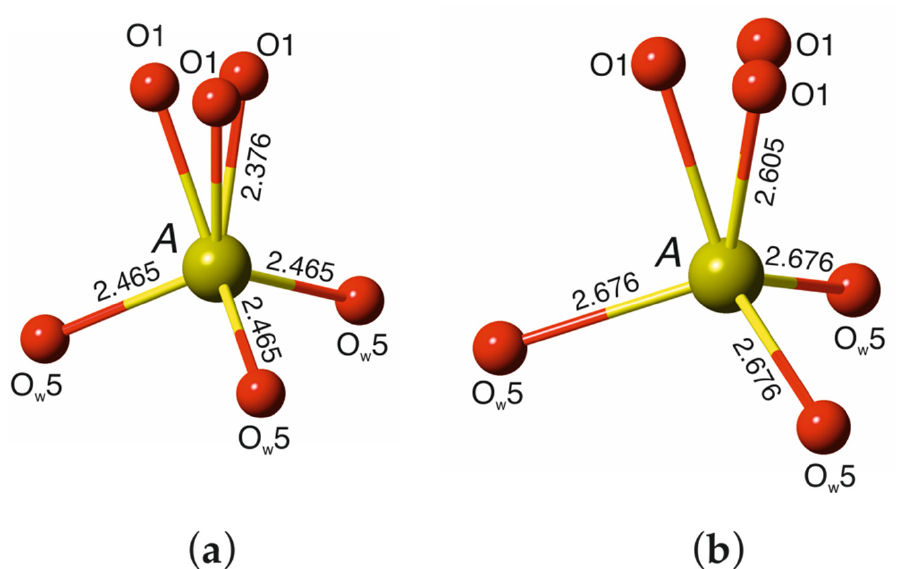
Figure 5. Coordination of the A site in natural ( a ) and synthetic ( b ) natrophosphate at room temperature. Legend as in Figure 4. The interatomic distances are given in Å.